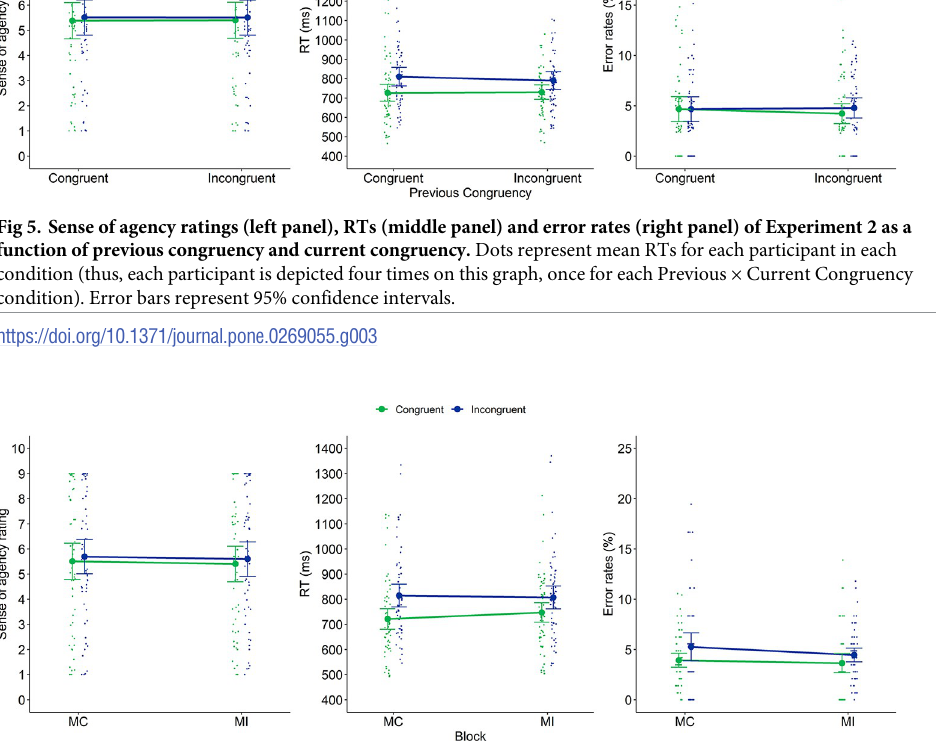
Fig 6. Sense of agency ratings (left panel), RTs (middle panel) and error rates (right panel) of Experiment 2 as a function of Block and current congruency. Dots represent mean RTs for each participant in each condition (thus, each participant is depicted four times on this graph, once for each Block × Current Congruency condition). Error bars represent 95% confidence intervals.